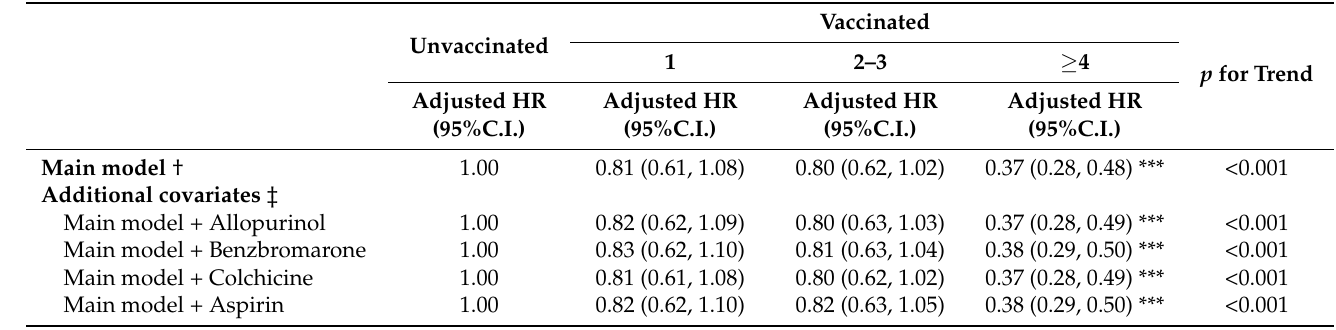
Table 3. Sensitivity analysis of adjusted HRs of vaccination in risk reduction of hemorrhagic stroke in all